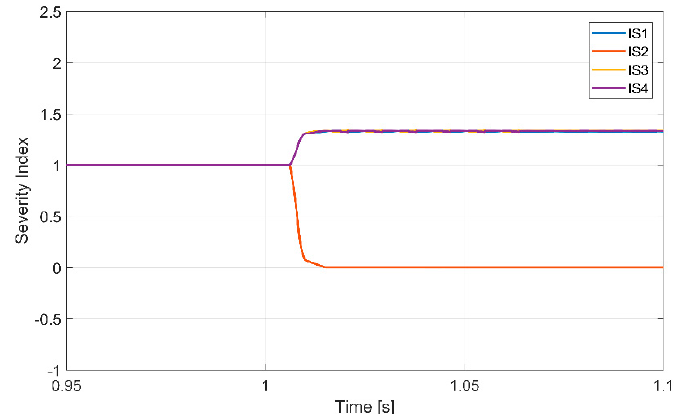
Figure 13. Diagnostic variables associated with the motor winding currents of the SRM at 2850 rpm in normal condition and open-circuit failure of power device S 1 C (simulation result).